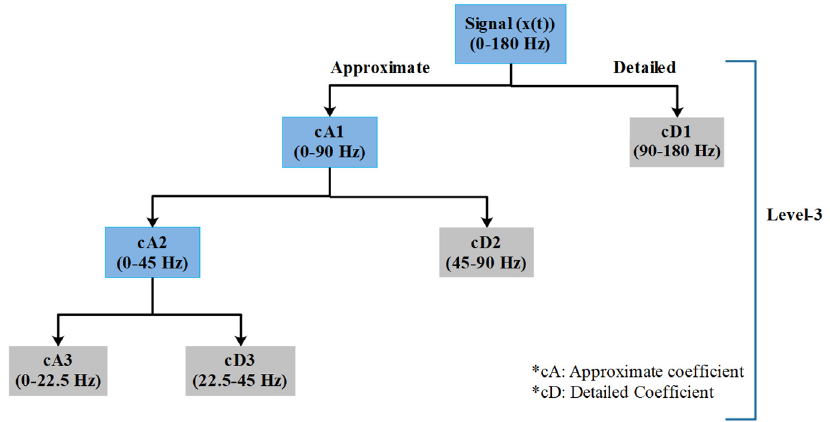
Figure 2. A schematic representation of the nodes from a 3-level DWT decomposition.